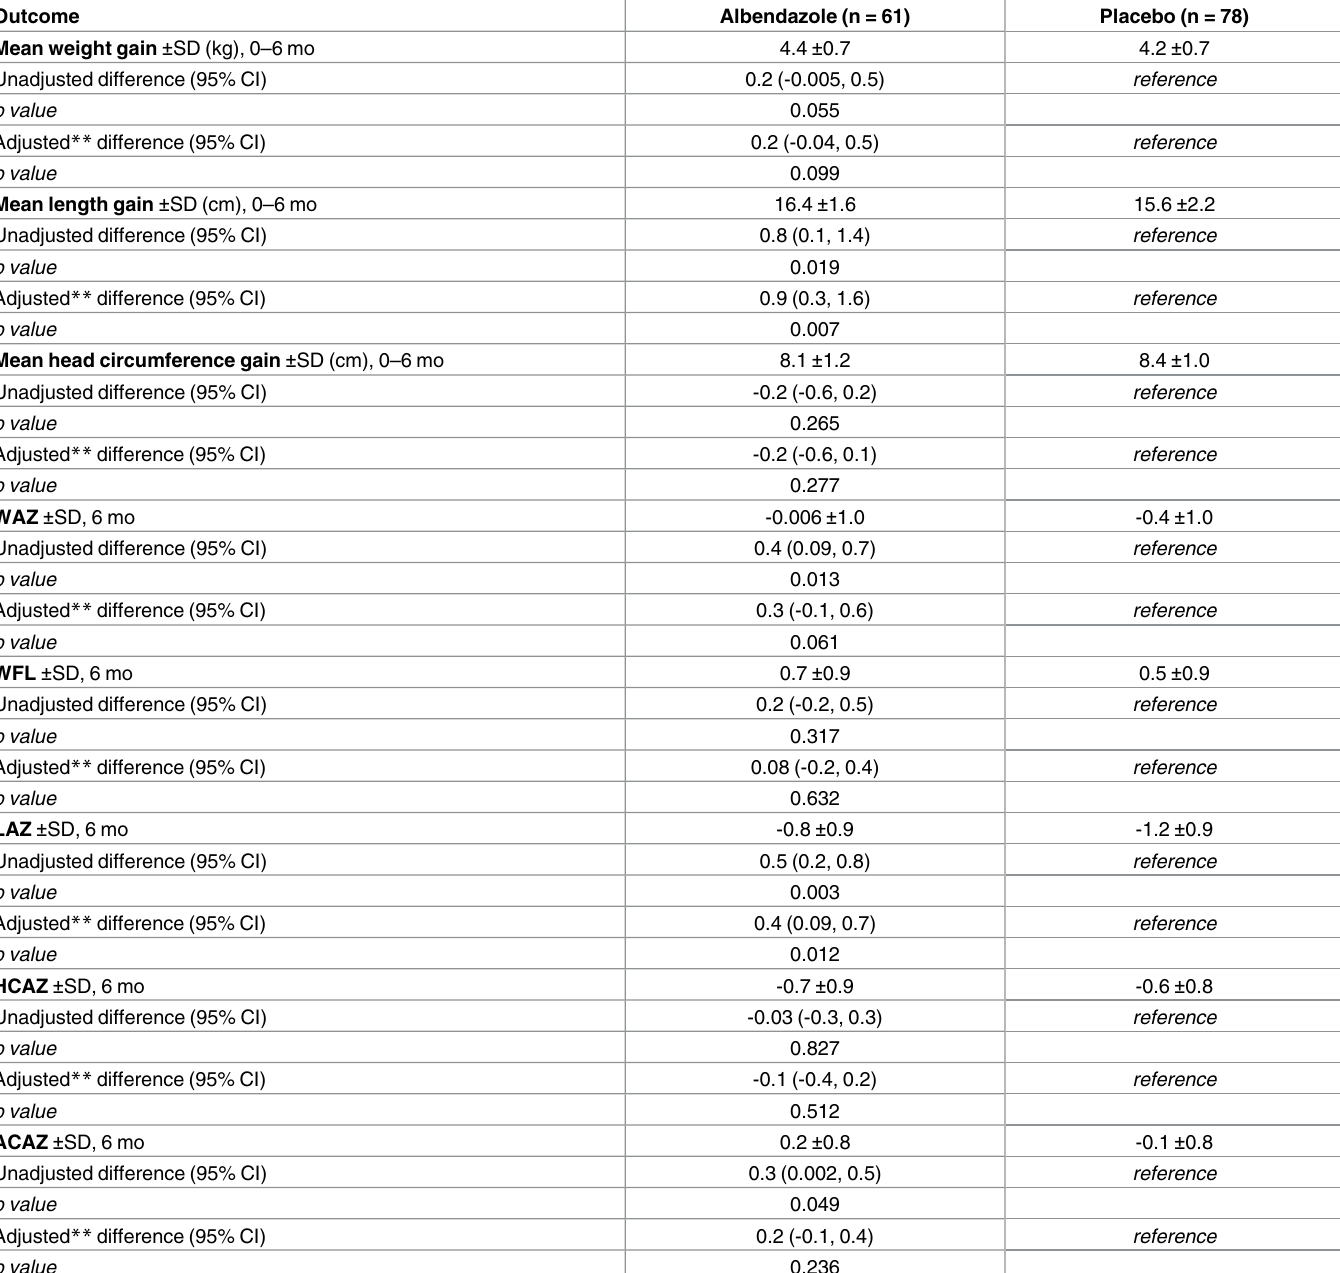
Table 5. Effect of maternal postpartum deworming on infant anthropometric outcomes over their first 6 months of life in women who tested posi- tive for infection with any helminth species at baseline (N = 139 * ),Iquitos, Peru (February 2014 –February